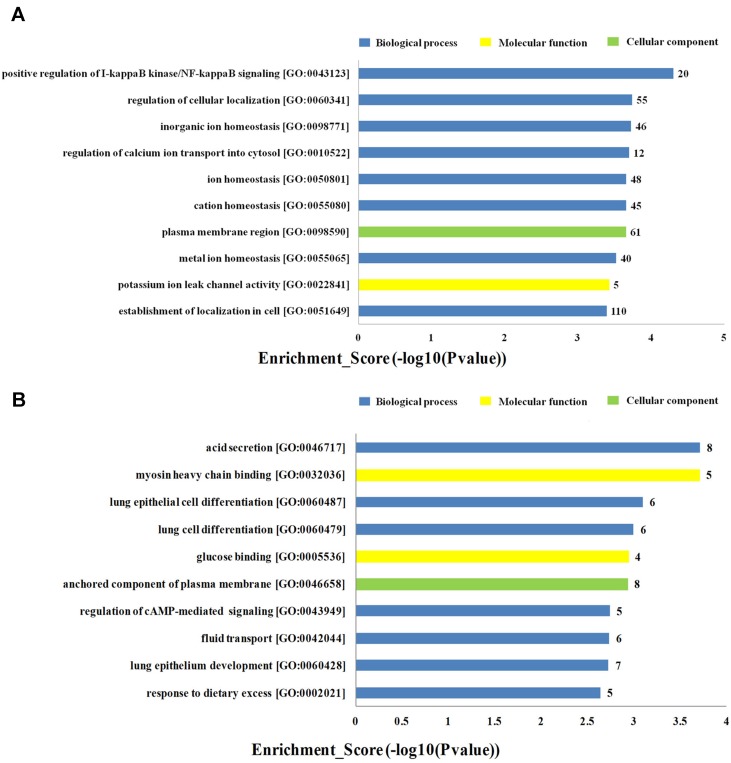
Top 20 GO terms for the differences in coexpressed long noncoding RNA (lncRNA) genes in the dilated cardiomyopathy (DCM) and ischemic cardiomyopathy (ICM) patients. The top 10 Gene Ontology (GO) terms that upregulated genes correlated with (A). The top 10 GO terms that downregulated genes correlated with (B). The bar plot shows the top 10 enrichment score [−log10(p-value)] value of the significant enrichment GO terms.